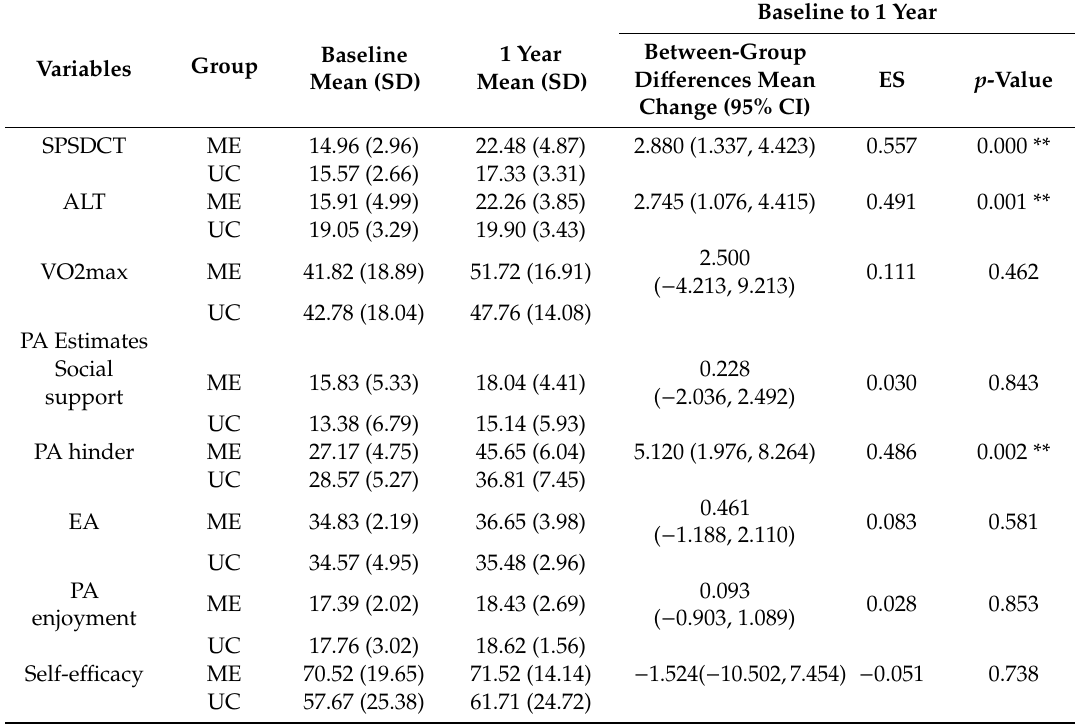
Table 3. Physical Activity (PA) estimates, muscle strength, and cardiopulmonary endurance 1-year